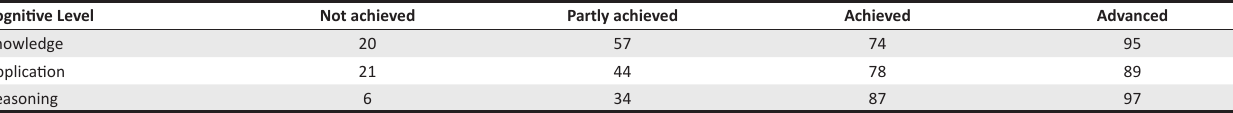
TABLE 6-A1: Mean score ( % ) by cognitive level and performance level. Cognitive Level